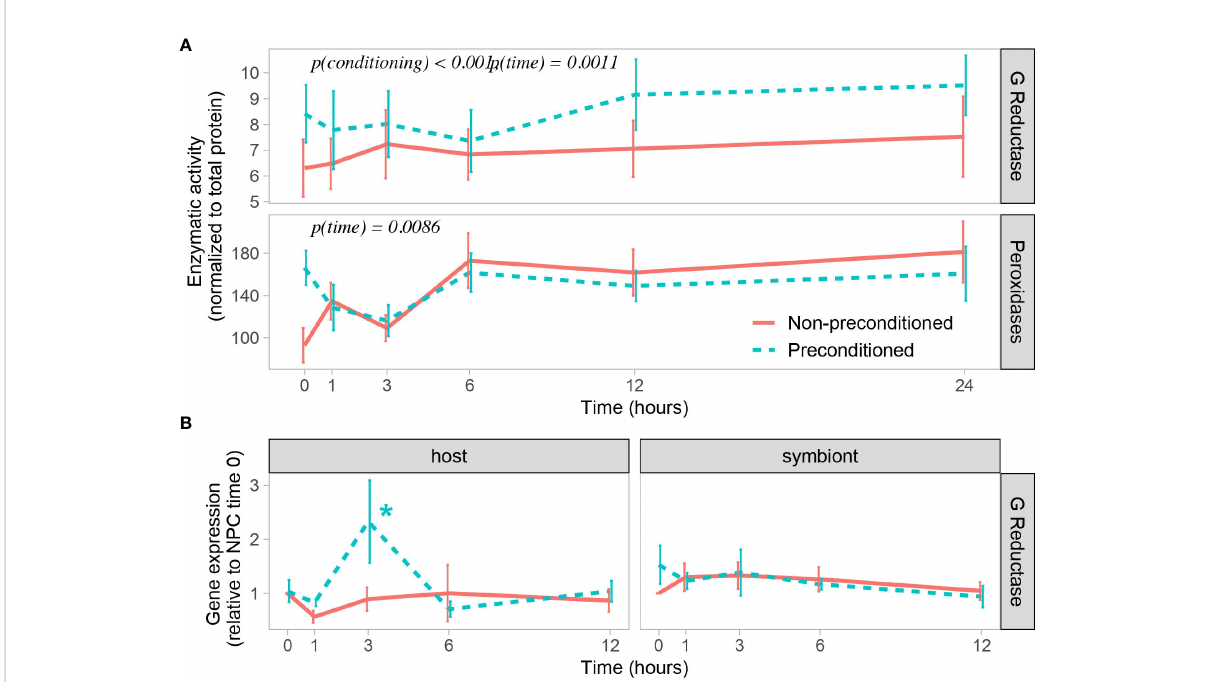
FIGURE 2 Enzymatic activity and gene expression during thermal stress. (A) Thermally PC corals have higher activity of glutathione reductase than NPC , but do not differ in the activity of peroxide-scavenging enzymes. Activity was measured in host cell extracts, n = 7. (B) Gene expression pattern of glutathione reductase in host and symbiont cells. Gene expression of host-derived glutathione reductase signi fi cantly increased at 3 hours of acute heat stress in PC corals, but not NPC corals. Graphs depict means with standard errors, n = 7. * represents p value <